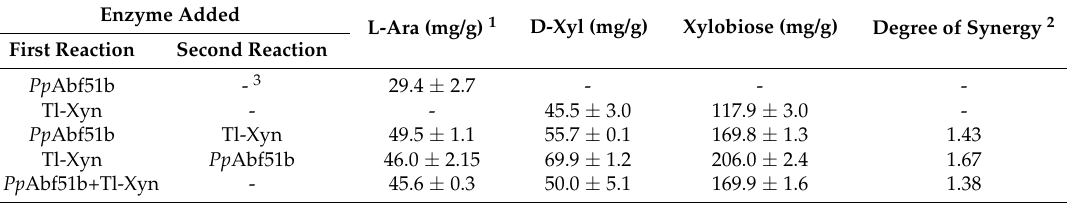
Figure 9. HPGPC analysis of the hydrolysis products of wheat arabinoxylan. Wheat arabinoxylan was hydrolyzed by Pp Abf51b, Pp Abf51b/Tl-Xyn (the simultaneous reaction), Pp Abf51b and Tl-Xyn (sequential enzyme combination with Pp Abf51b added firstly), or Tl-Xyn and Pp Abf51b (sequential enzyme combination with Tl-Xyn added firstly). Control: wheat arabinoxylan. Table 5. Synergistic effect of Pp Abf51b and T. longibrachiatum endo-1, 4- β -Xylanase Tl-Xyn.